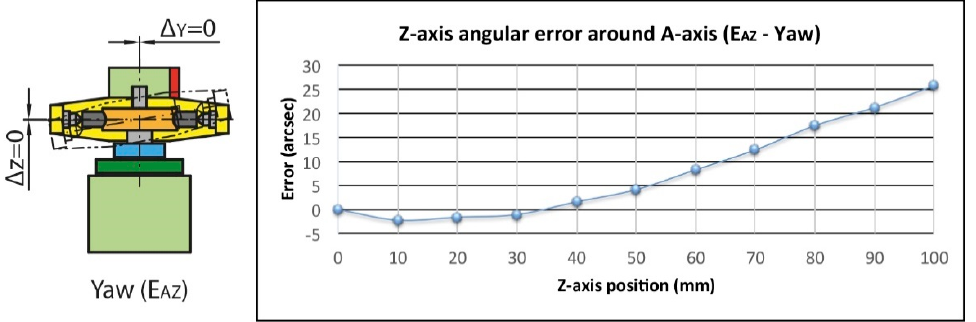
Figure 14. Yaw error (E AZ ).